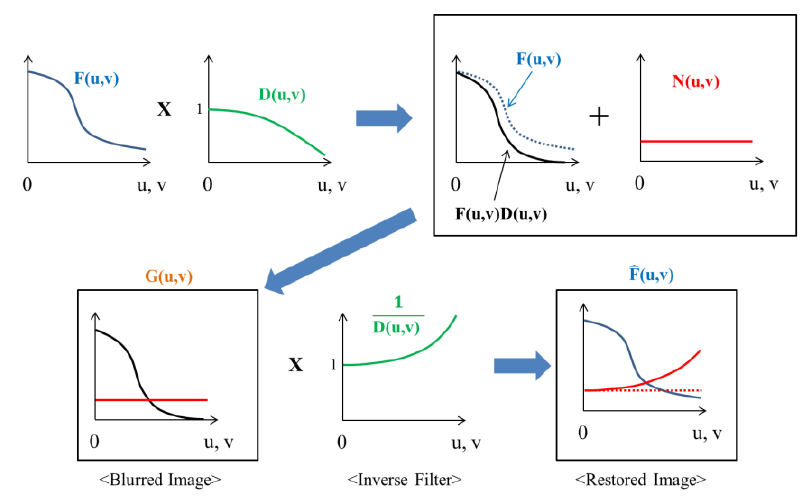
Figure 11. Schematic diagram of noise amplification.